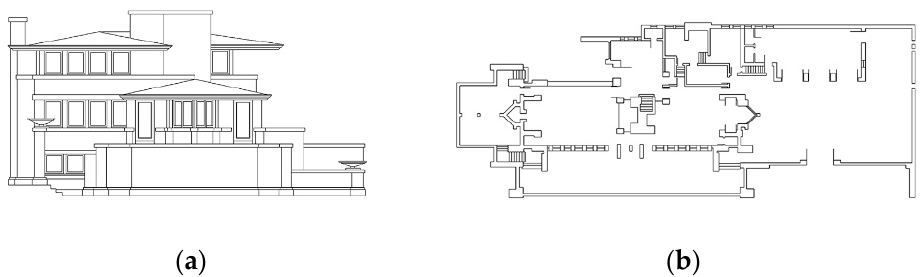
Figure 1. Robie House (1909), an exemplar of Wright’s Prairie style. ( a ) Elevation and ( b ) plan. Despite its initial success, Wright’s focus on the Prairie Style began to wane after